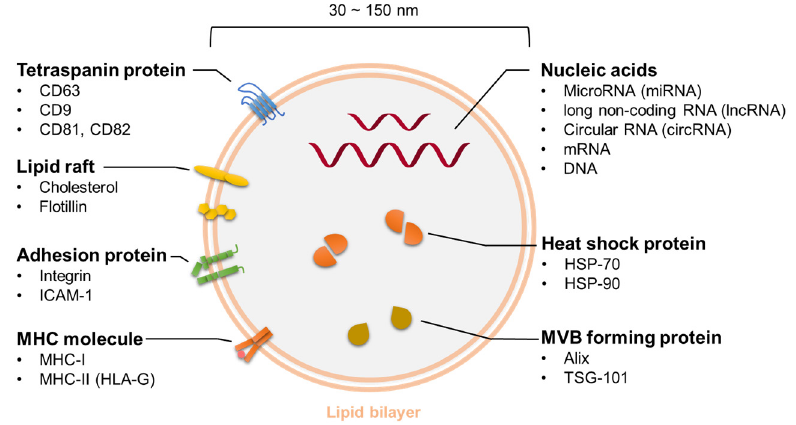
Figure 2. Various molecules are contained within the vesicle and on the surface of the membrane.